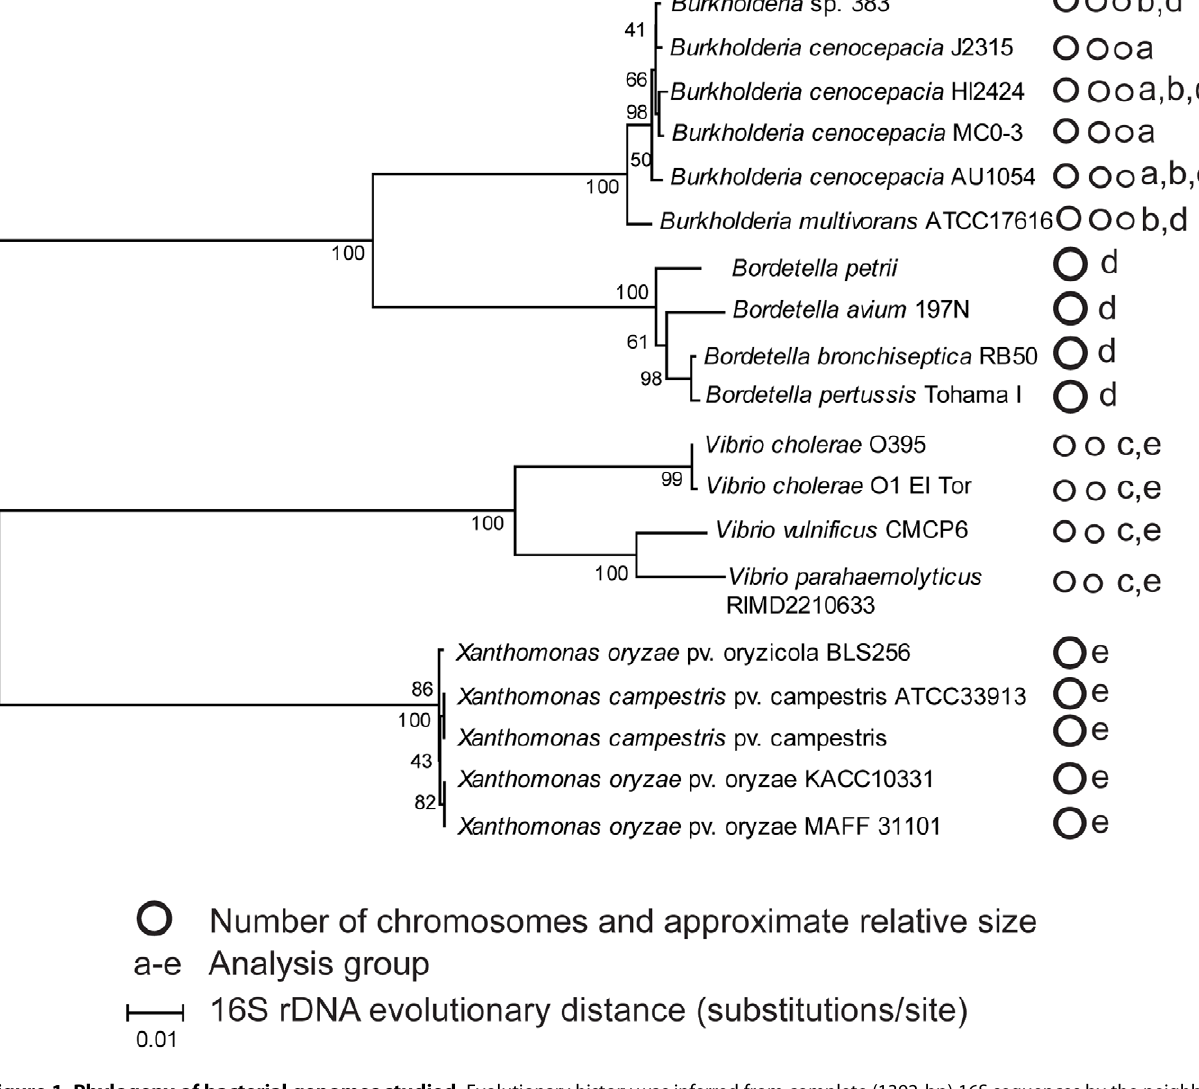
Figure 1. Phylogeny of bacterial genomes studied. Evolutionary history was inferred from complete (1392 bp) 16S sequences by the neighbor- joining method; the bootstrap consensus tree from 500 replicates is shown. Distances were calculated by the maximum composite likelihood method. Analysis was conducted using MEGA4 [46]. Panortholog sets were identified within five genome groups, denoted a–e. B. cenocepacia strain PC184 was included in analysis group ‘a’ but its complete 16S sequence was unavailable.